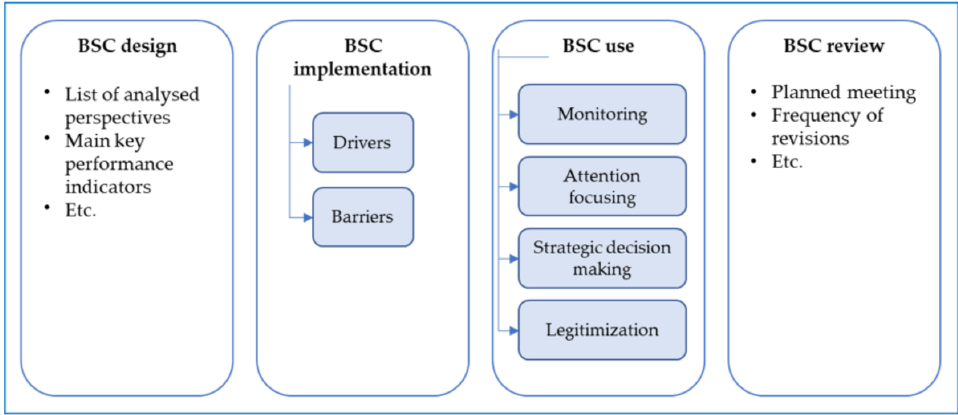
Figure 2. The framework adopted for data